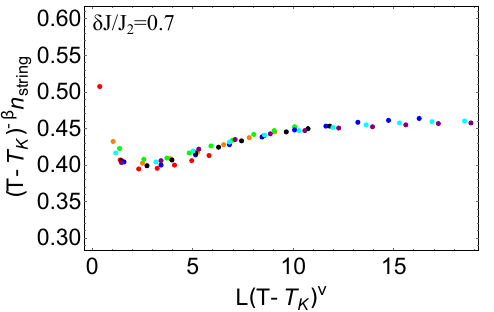
Figure 29: Data collapse demonstrating a Pokrovsky-Talapov tricritical point. The model in question = 0.7. Simulations are run on hexagonal is H ABB2 [ Eq. 69 ] in the constrained manifold and δ J / J 2 clusters with N = 3 L 2 and L = 24 (red), L = 36 (orange), L = 48 (green), L = 72 (blue), L = 96 (black), L = 144 (cyan), L = 192 (purple). The data are plotted according to the scaling hypothesis given in Eq. 88, and the best collapse is found for β = 0.21 ± 0.04 and ν (cid:107) = 0.91 ± 0.25. This is consistent with β = 1 / 4, which is the expected value at a Pokrovsky-Talapov tricritical